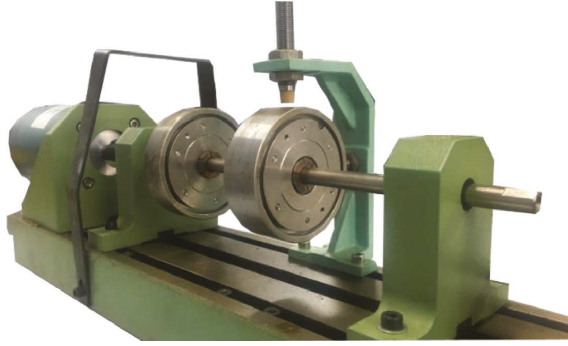
Figure 10: ZT-3 rotor test